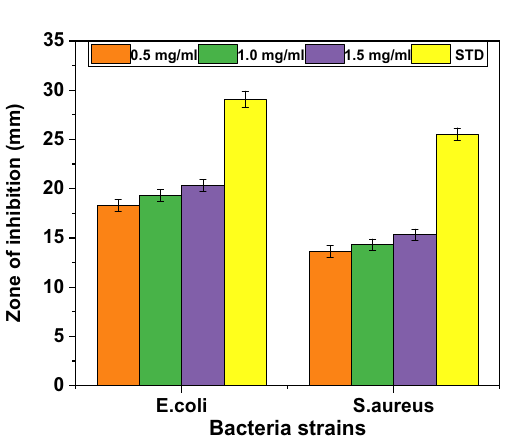
E.coli Figure 8. Antibacterial activity of synthesized Ag–ZnO against Escherichia coli and Staphylococcus aureus at different minimum inhibitory concentration